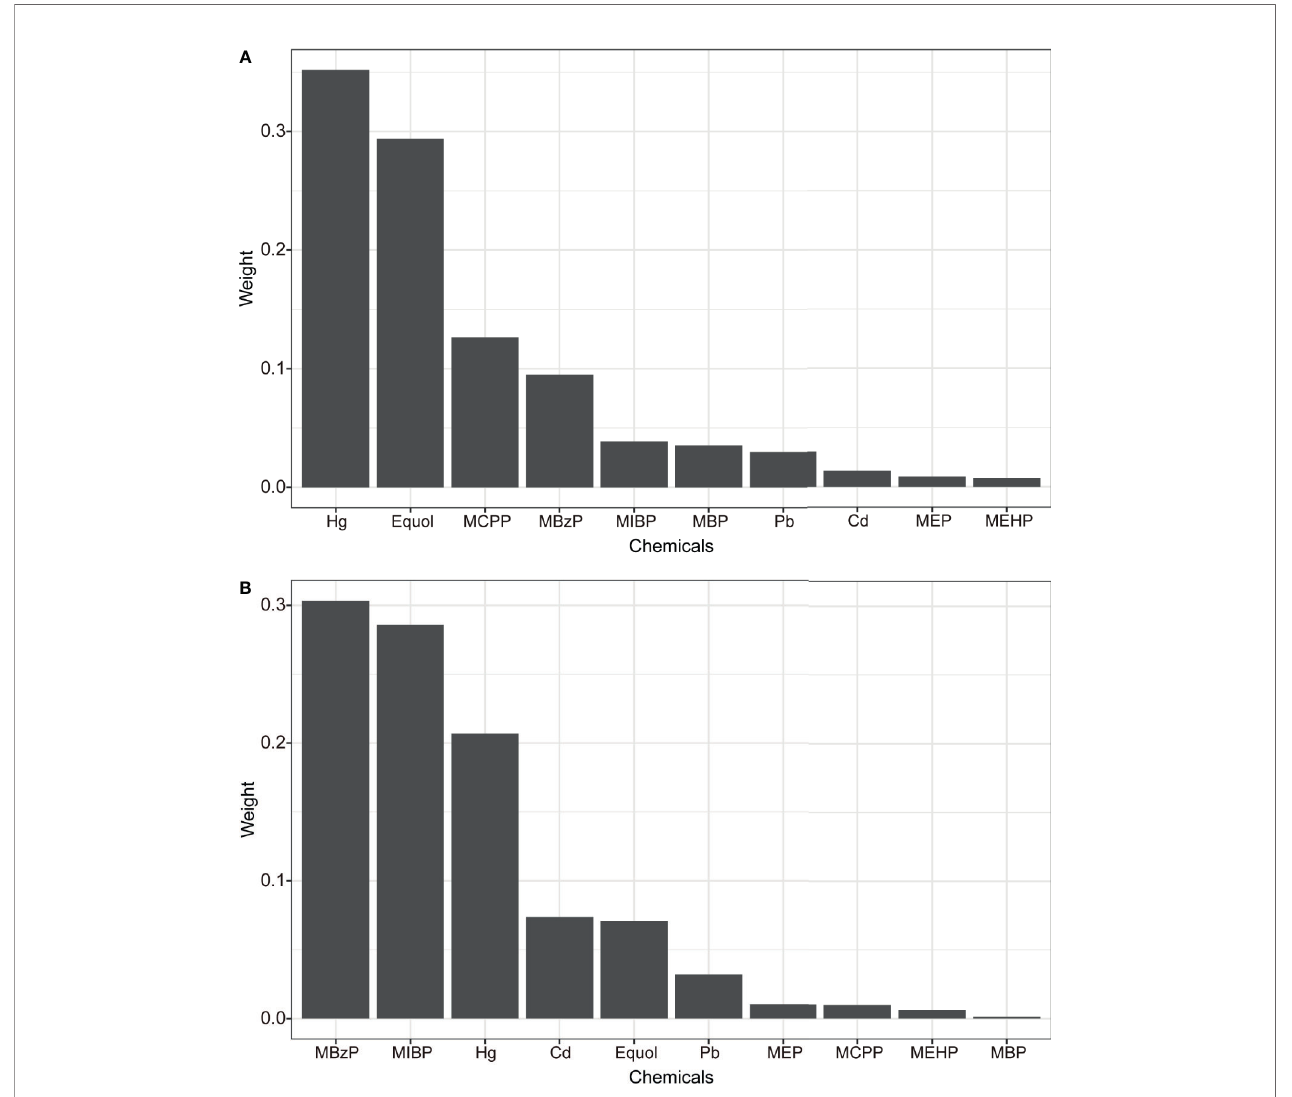
FIGURE 2 | The weights of each chemical in positive WQS model regression index for uterine leiomyomata (A) and endometriosis (B) . Models were adjusted for age, ethnicity, BMI group, ovary removal, female hormone usage, pregnant status, menopause status, and log-transformed urinary creatinine